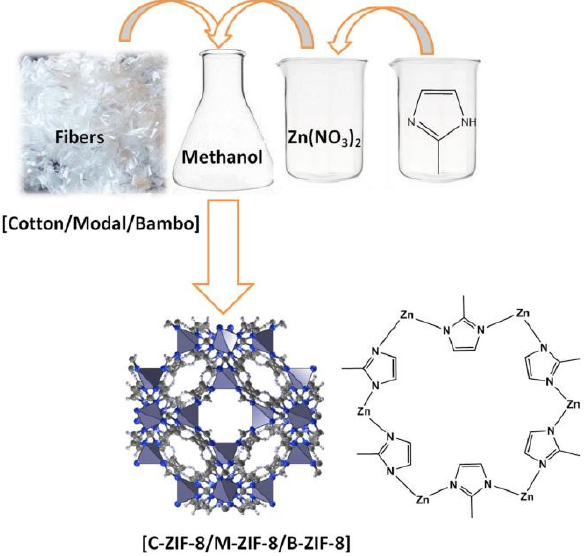
Figure 6. Synthesize scheme of ZIF-8 using different cellulosic fiber templates [63].